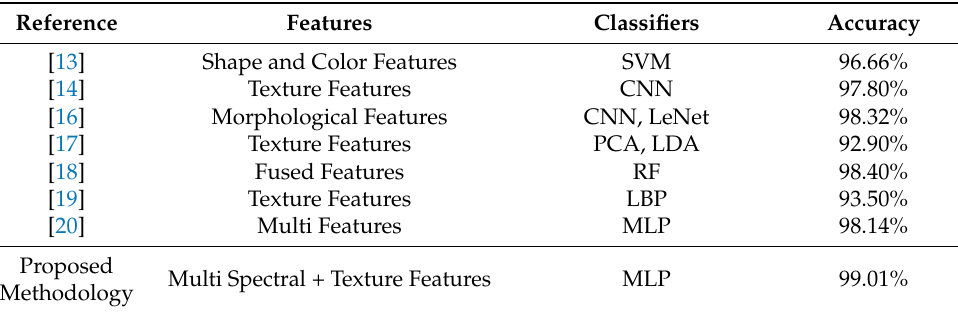
Table 6. Comparison of proposed methodology with existing methodologies.